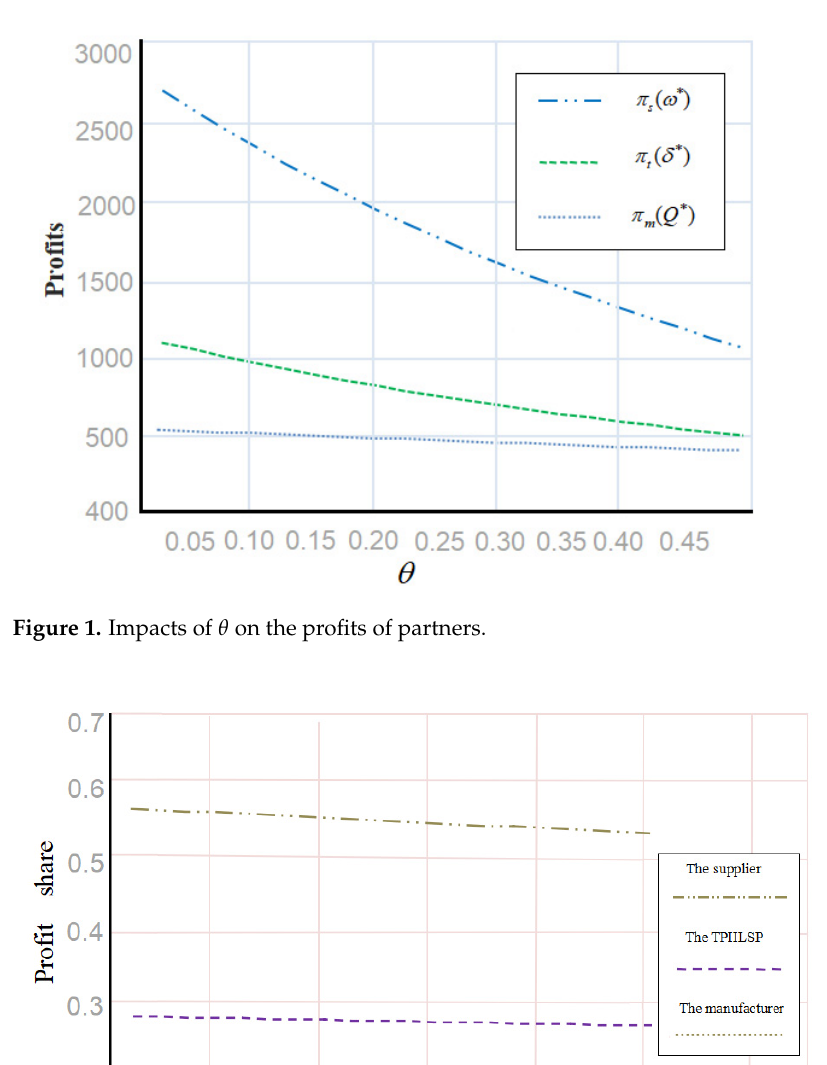
Table 1. Effects of tariff rate on order quantity and FOB price in MT and ST alliance decisions.